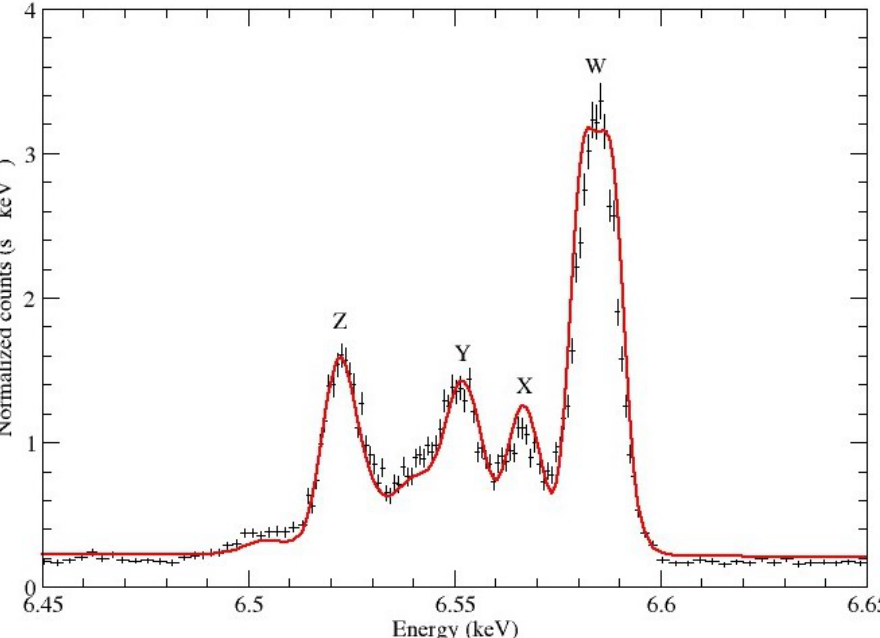
Figure 1. HITOMI spectrum of the Perseus Cluster in the Fe XXV “triplet” spectral region (6.50–6.60 keV) [47] showing the XSTAR fit (red line). With the higher resolution, the He-like “triplet” becomes a quartet comprising the resonance (w), magnetic quadrupole (x), intercombi- nation (y), and magnetic dipole (z) lines. Other Fe satellite lines begin to be detectable (e.g., the bump at ∼ 6.5